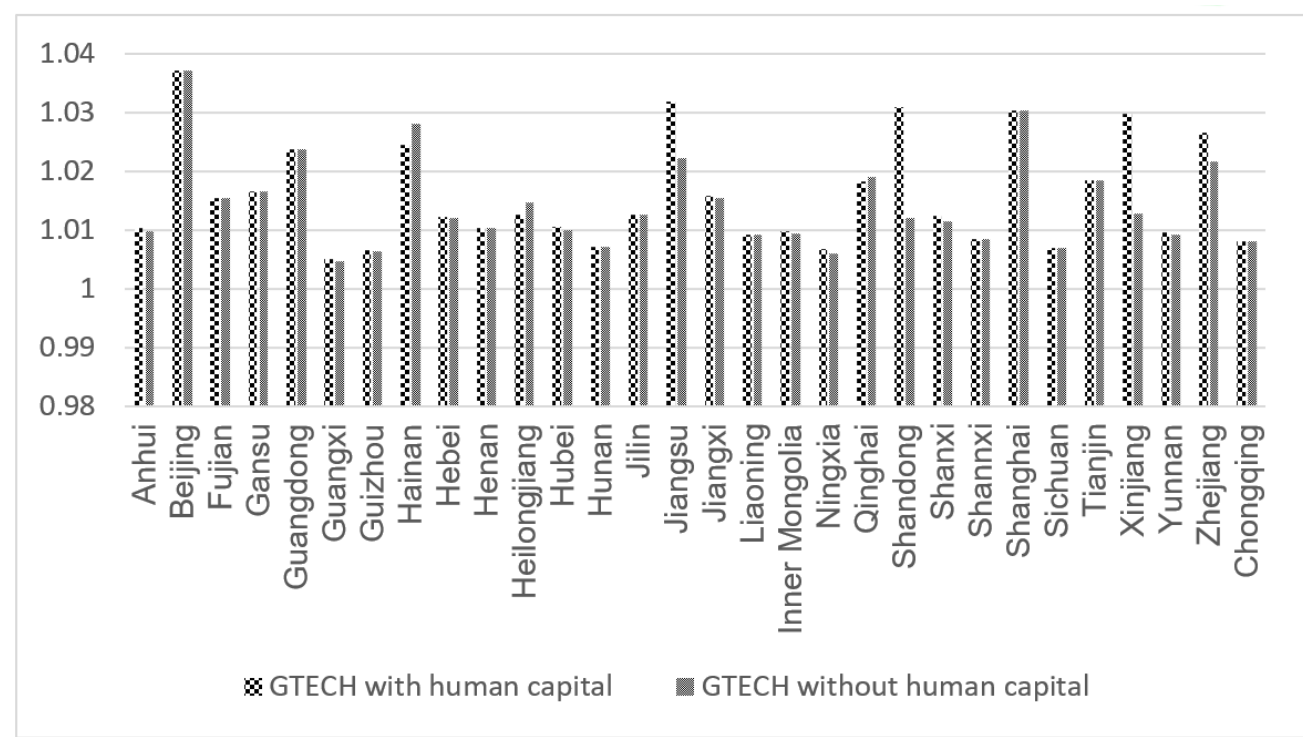
Figure 6. Comparison of technical efficiency among provinces and cities.